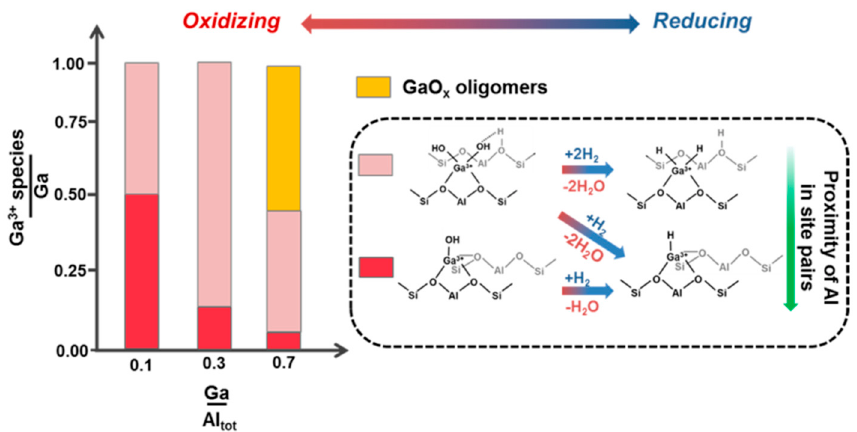
Figure 3. Ga 3+ species in Ga/H-MFI under oxidizing (red) and reducing conditions (blue). Reprinted with permission from ref. [83]. Copyright 2018 American Chemical Society.